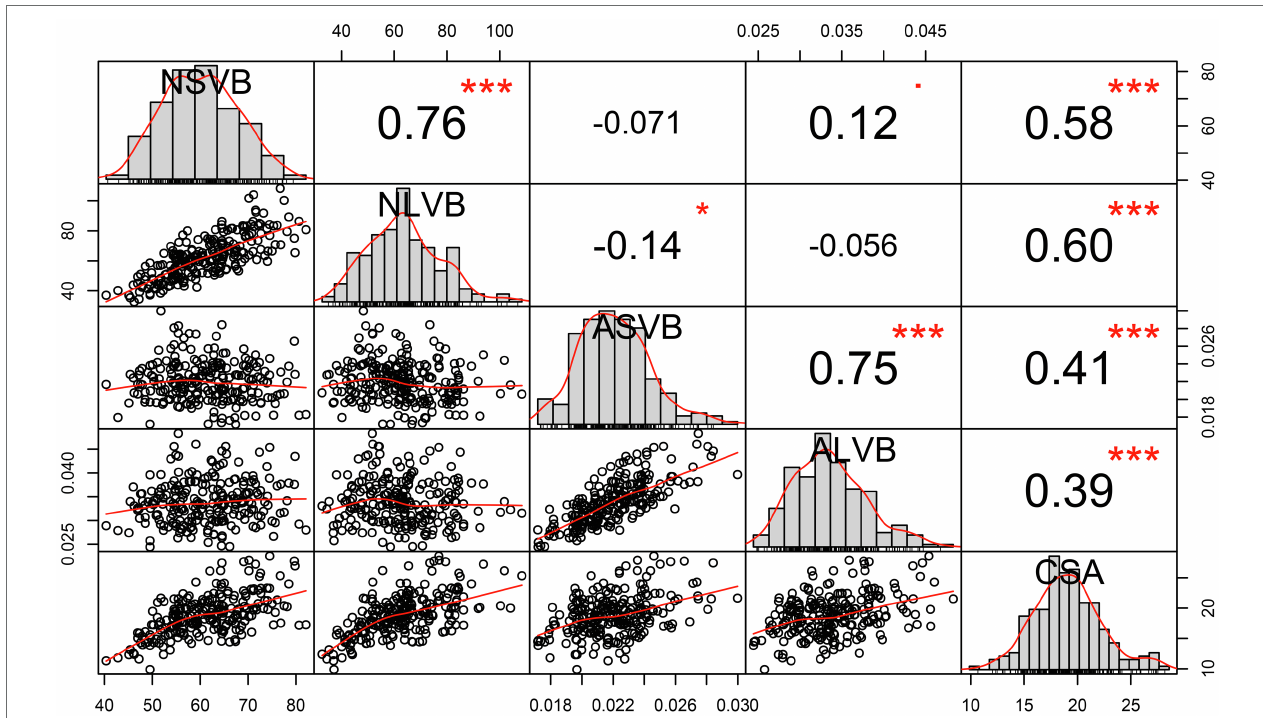
FIGURE 2 | Correlation analysis of BLUP data for vascular bundle-related traits. NSVB, number of small vascular bundle; NLVB, number of large vascular bundle; ASVB, average area of single small vascular bundle; ALVB, average area of single large vascular bundle; and CSA, cross-sectional area. *Significant at 0.05 probability level. ***Significant at 0.001 probability level.